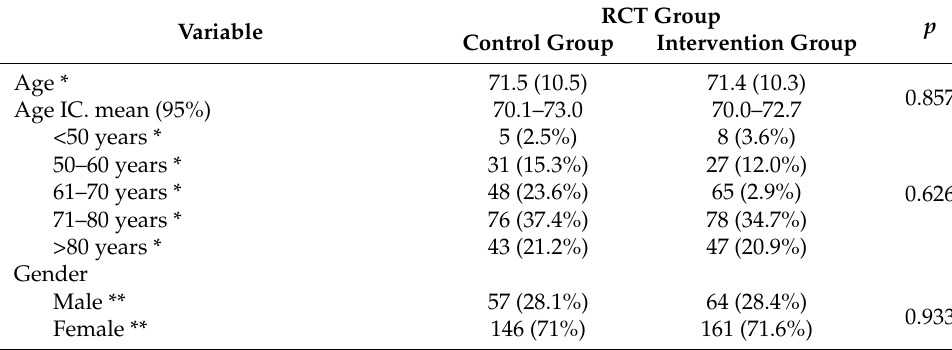
Table 1. Sociodemographic and clinical data of the RCT sample (CG and IG) at the baseline (month